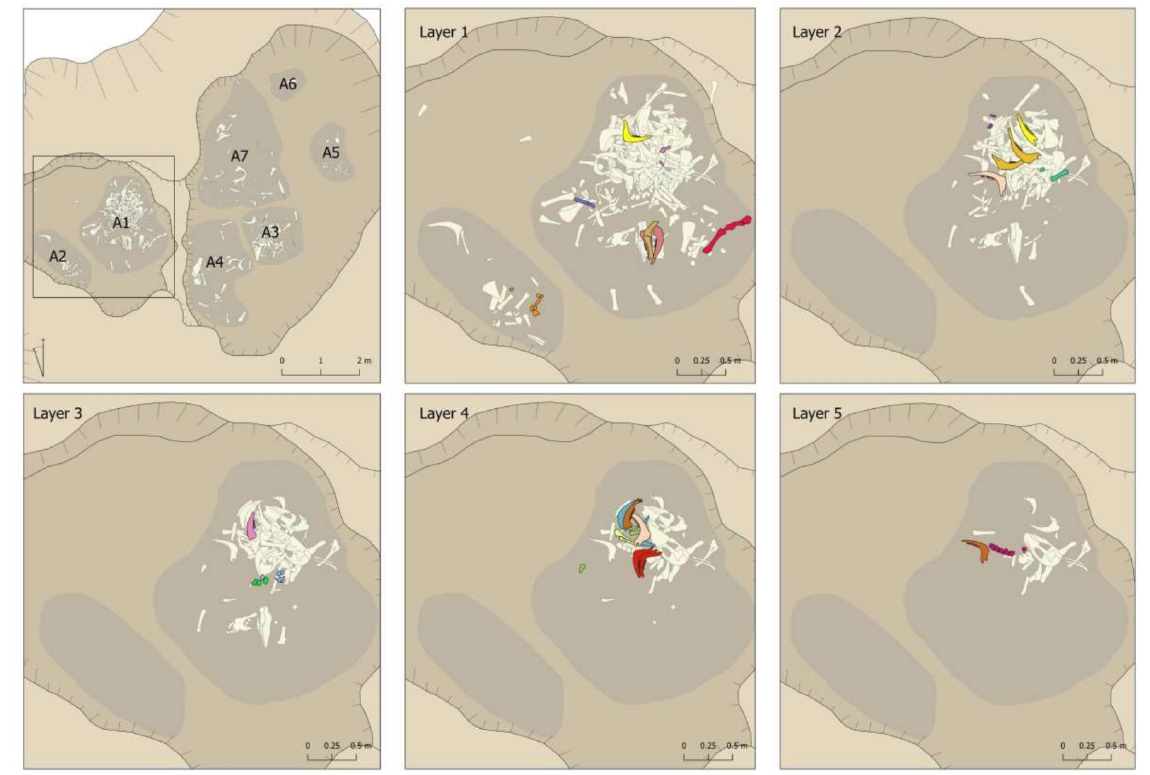
Figure 13. Connections documented in the different layers of Areas 1 and 2 of the Vilauba pit.